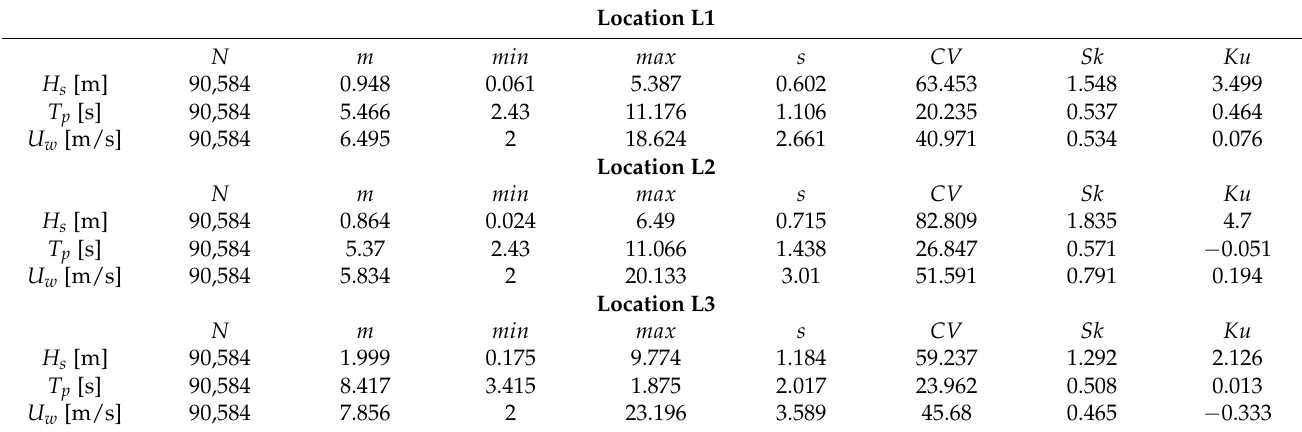
Table 4. Statistical characteristics of wind and wave time series at the examined locations. Location